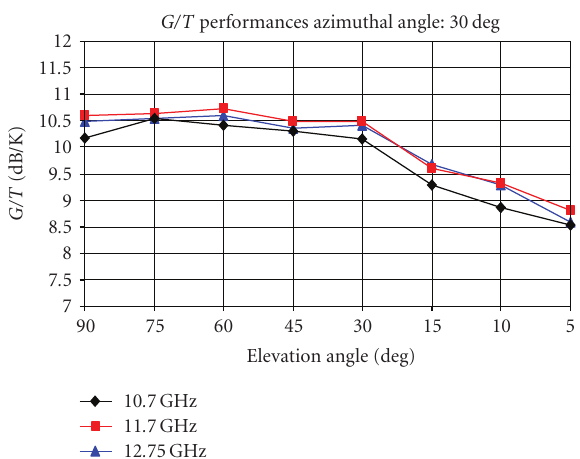
Figure 16: G/T versus elevation angle over the horizon.